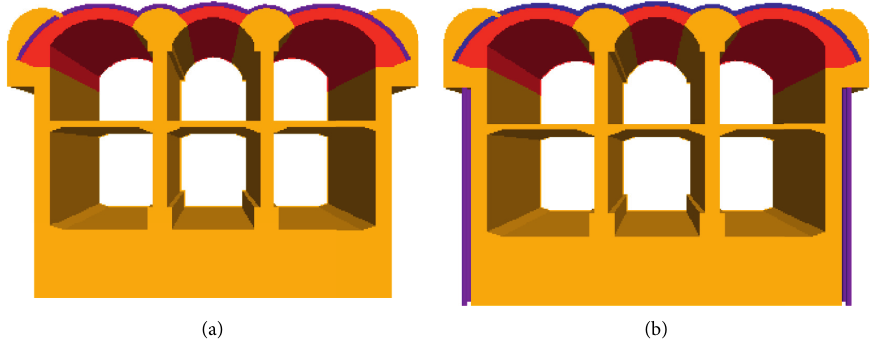
Figure 18: The support structure of the station with and without steel pipe piles. (a) Without side piles. (b) With side piles.